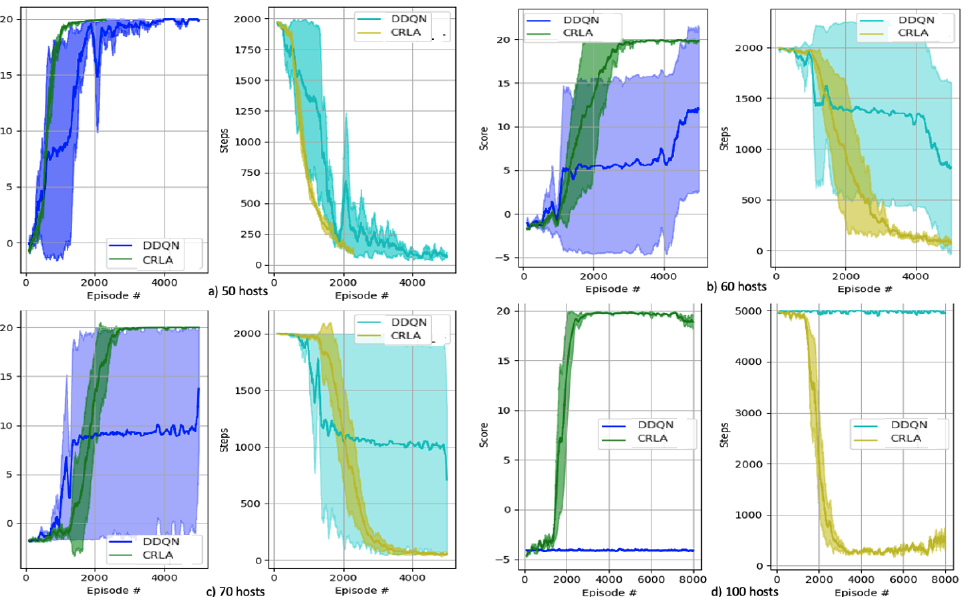
Figure 7. Results of CRLA and single DDQN on different CybORG scenarios. Sub-figures from left to right, top to bottom: ( a ) 50-hosts scenario, ( b ) 60-hosts scenario, ( c ) 70-hosts scenario, ( d ) 100-hosts